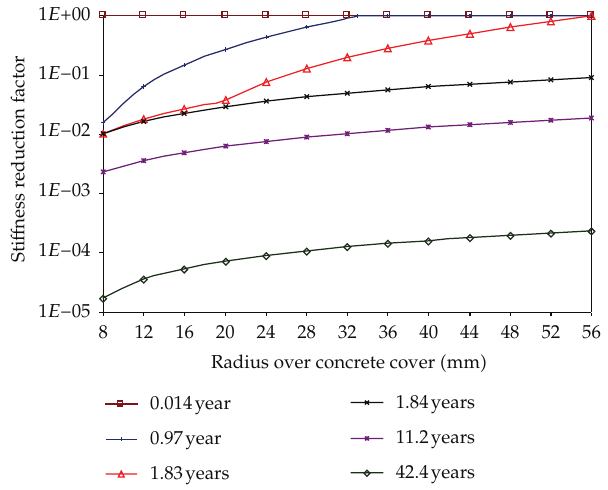
Figure 12: Sti ff ness reduction factor (cid:5) β (cid:6) varying over concrete cover at various